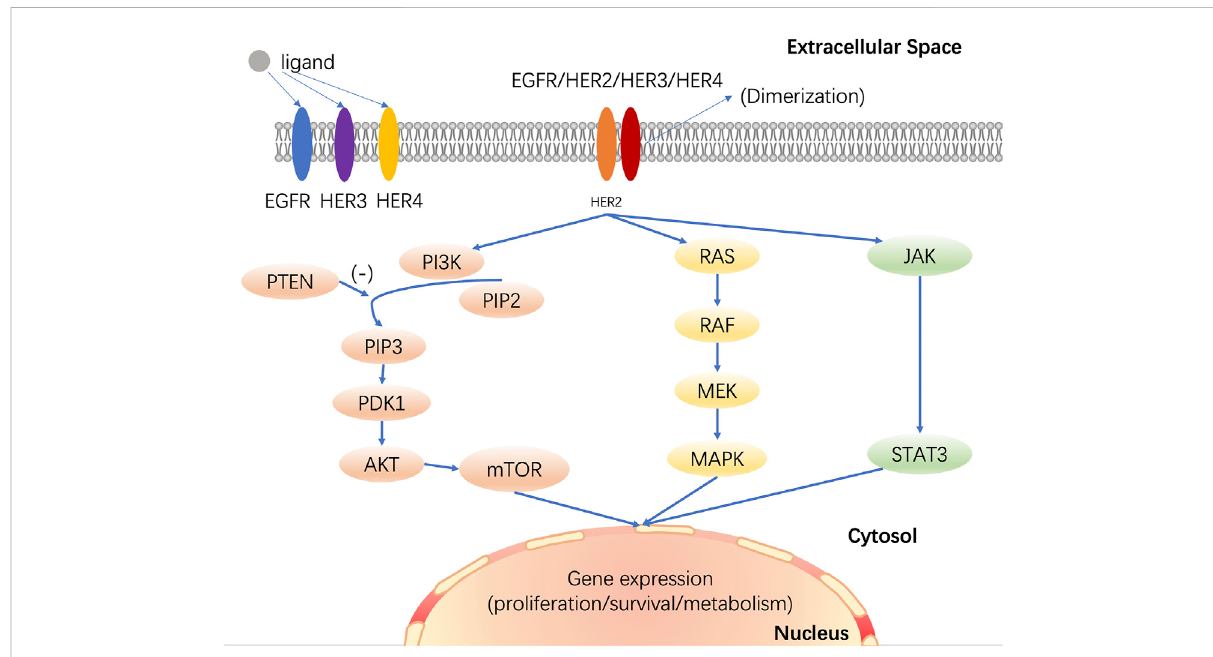
FIGURE 1 HER2 mediates multiple signaling pathways in breast cancer. HER2 dimerizes with other members of the EGFR family, activates downstream signaling pathways, and then regulates cell growth, proliferation, differentiation, apoptosis, and metastasis. PI3K: phosphoinositide 3-kinase; PTEN: phosphatase and tensin homolog deleted on chromosome ten; PIP2: phosphati-dylinositol-4,5-bisphosphate; PIP3: phosphatidylinositol-3,4,5- trisphosphate; PDK1: 3-phosphoinositide-dependent protein kinase 1; AKT: protein kinase B; mTOR: mammalian target of rapamycin; MAPK: mitogen-activated protein kinase; JAK: janus-activated kinase; STAT: signal transducer and activator of